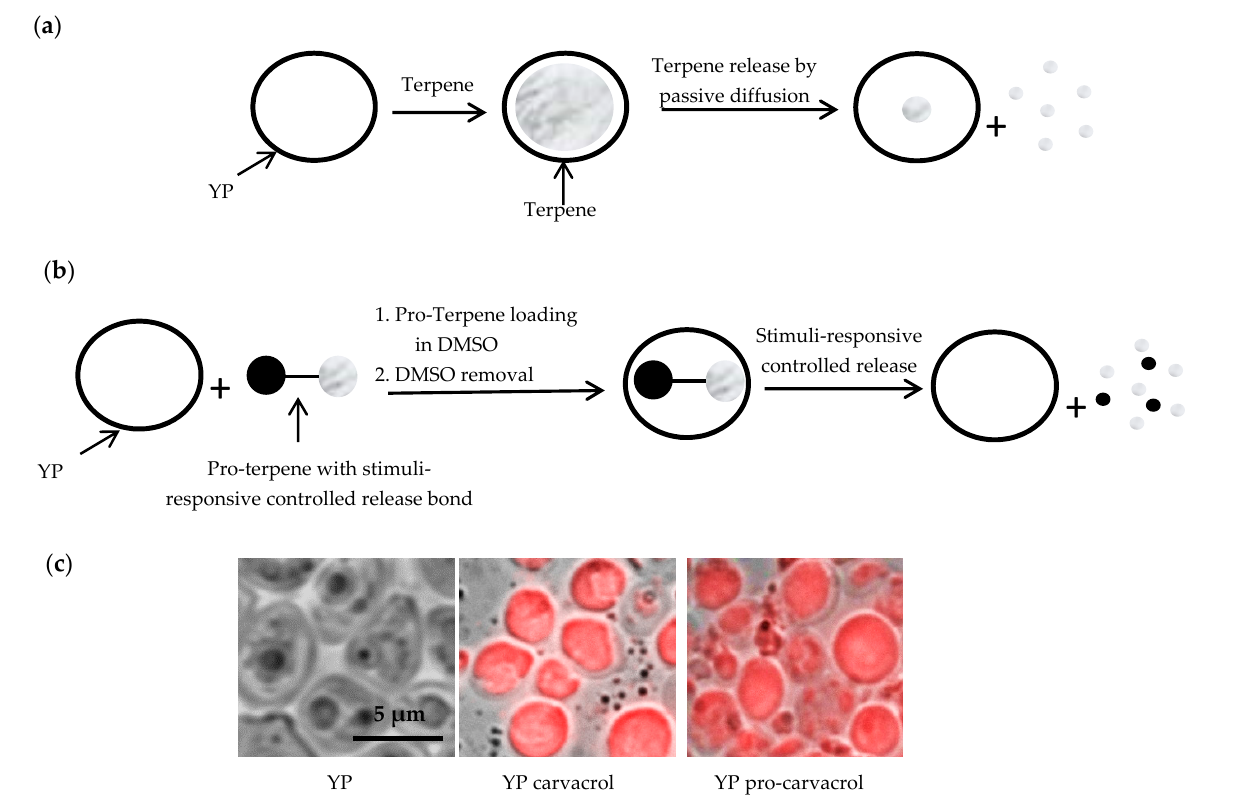
Figure 2. Schematics of ( a ) diffusion-controlled terpene loading in YPs and terpene release, ( b ) pro-terpene loading in YPs and stimuli-controlled terpene release and ( c ) microscopy images of Nile red stained YP control and YPs loaded with carvacrol and pro-carvacrol.